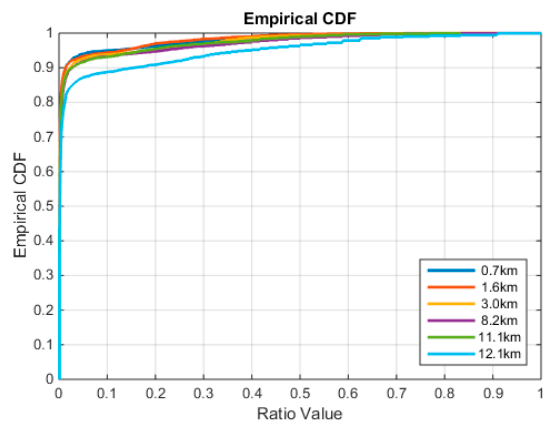
Figure 14. The CDF of the ratio value subjected to different distances to the VRS. Table 1. Reliability of the network RTK positioning with different distances to the VRS. Distance to the VRS (km) Fix Rate (Ratio